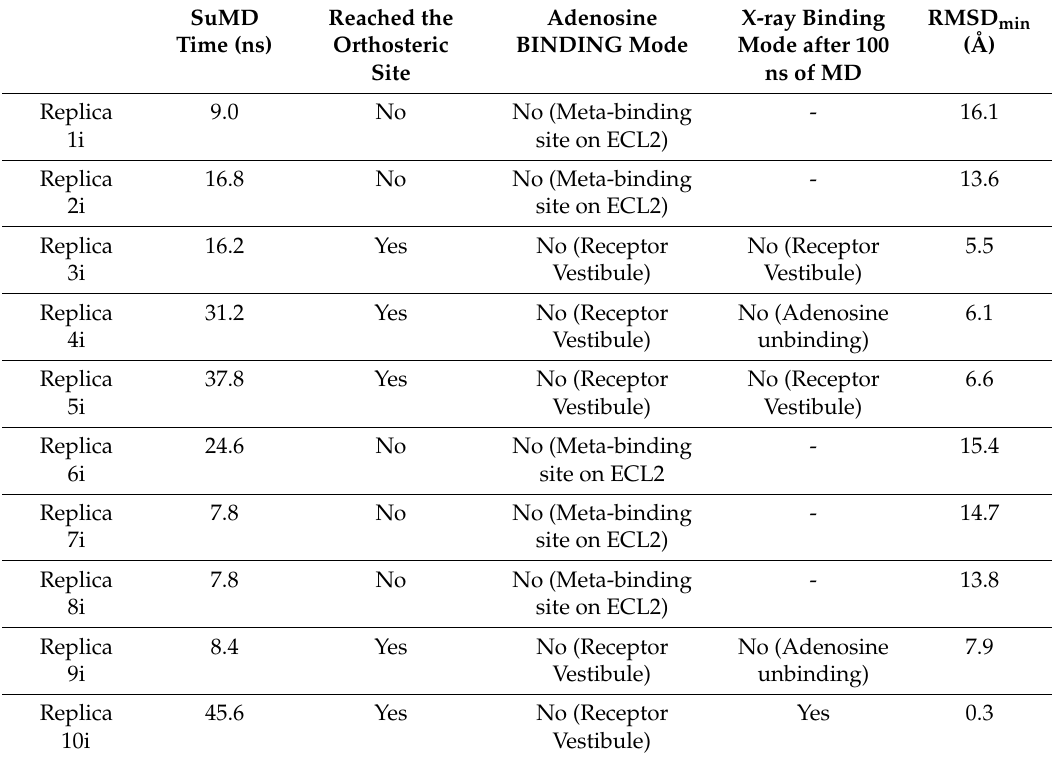
Table 4. Summary of the adenosine SuMD simulations performed on the inactive conformation of the A 2A AR. For each replicate, the SuMD simulation time required, the positive or negative outcome, and the binding mode sampled at the end are reported along with the RMSDmin (calculated using 2YDO as a